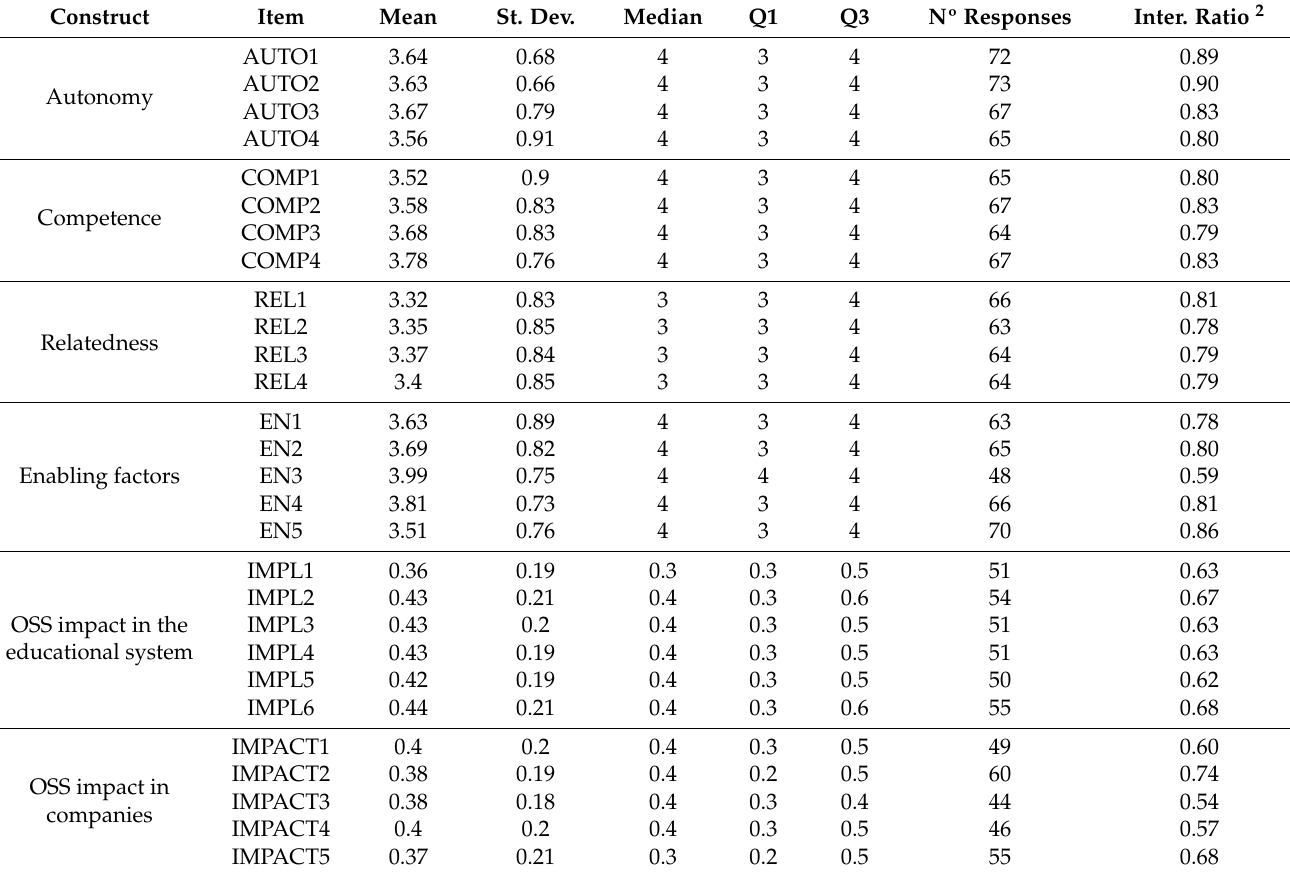
Table 3. Results in the second round 1